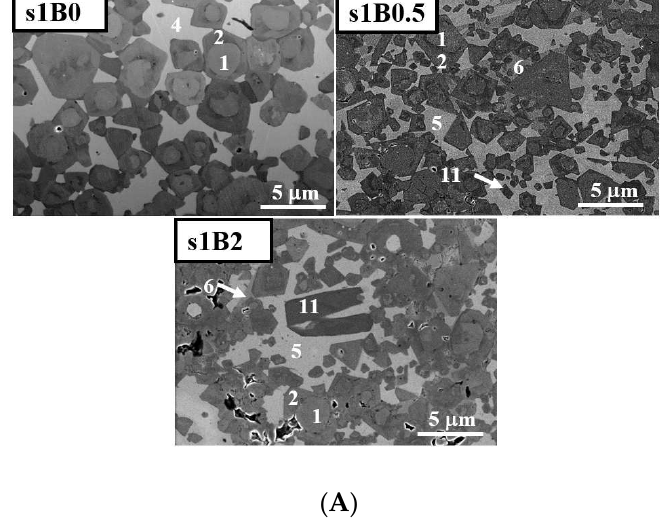
7 of 12 Table 1. Semiquantitative transition metals composition (Ti, Ta, and Co) in atomic percentage (at. %) 252 for both sets of (Ti,Ta)(C,N)-Co-B based cermets: s1B0 , s1B0.5 , s1B2 , s2B0 , s2B0.5 , and s2B2 . 253